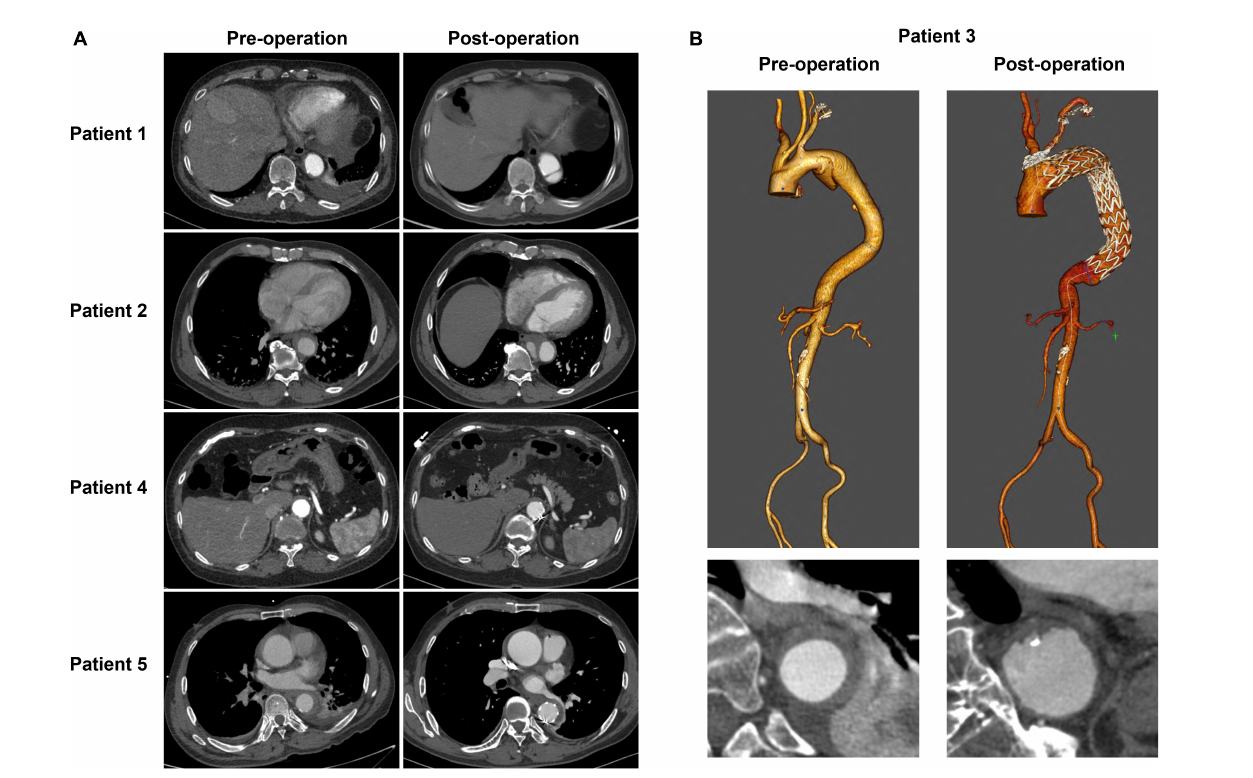
FIGURE3 The CTA image changes of five TEVAR patients during follow-up. (A) The cross-section images of patient1, 2, 4, and 5. (B) 3D reconstruction of CTA image of patient